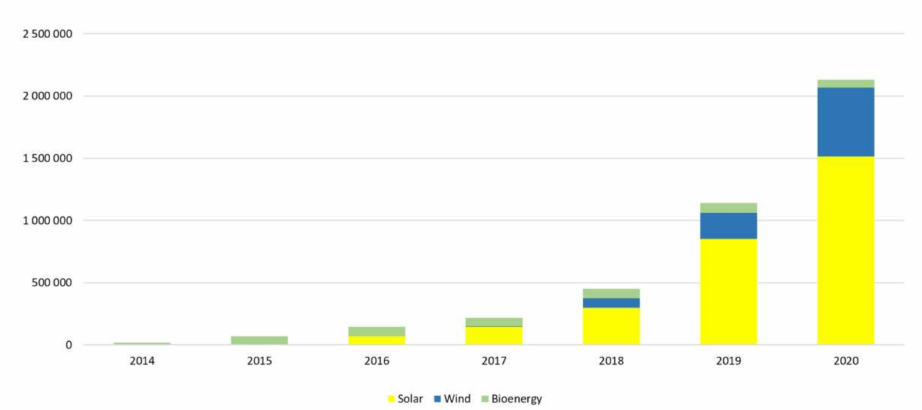
Figure 1. The volume of electricity generation at qualified renewable energy facilities in the retail and wholesale markets, confirmed by certificates (thousand kW per hour of installed capacity)